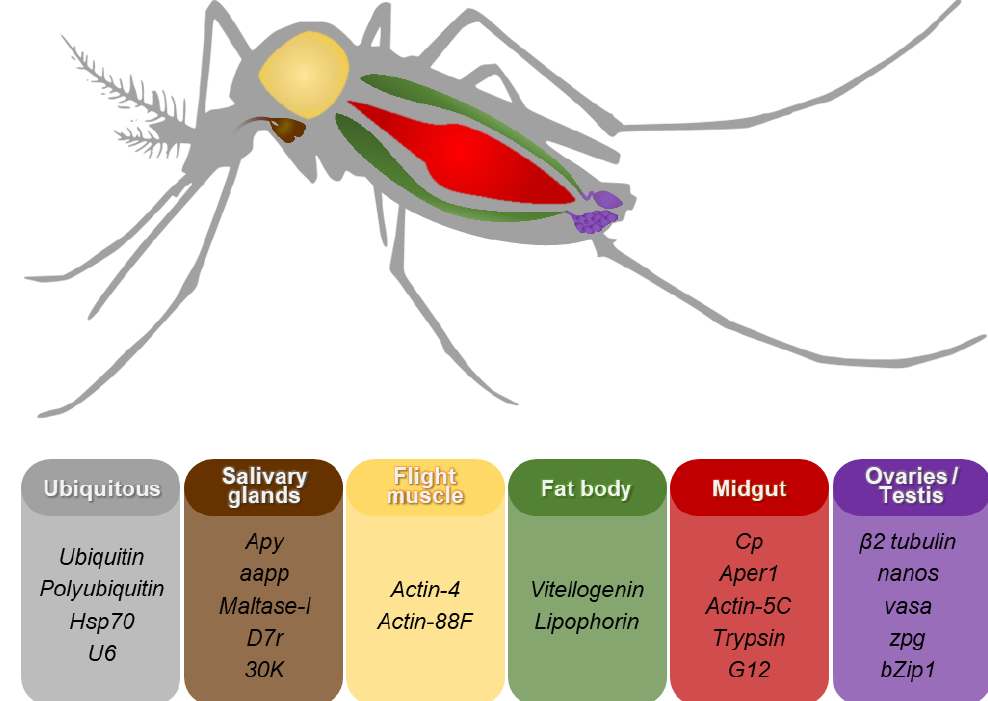
Figure 1. Genes whose promoters and 5′ - and 3′ end DNA sequences are used in genetic engineering of mosquitoes. The promoters and control DNA of a number of genes have been used to drive expression of genetic components or effector molecules in different tissues of the mosquito. Details and references on the promoters listed are included in the text. Abbreviations: aapp , anopheline antiplatelet gene; Aper1 , adult peritrophic matrix gene; Apy , apyrase; Cp , zinc carboxypeptidase A1; D7r , D7-related gene; Hsp70 , heat-shock protein 70.